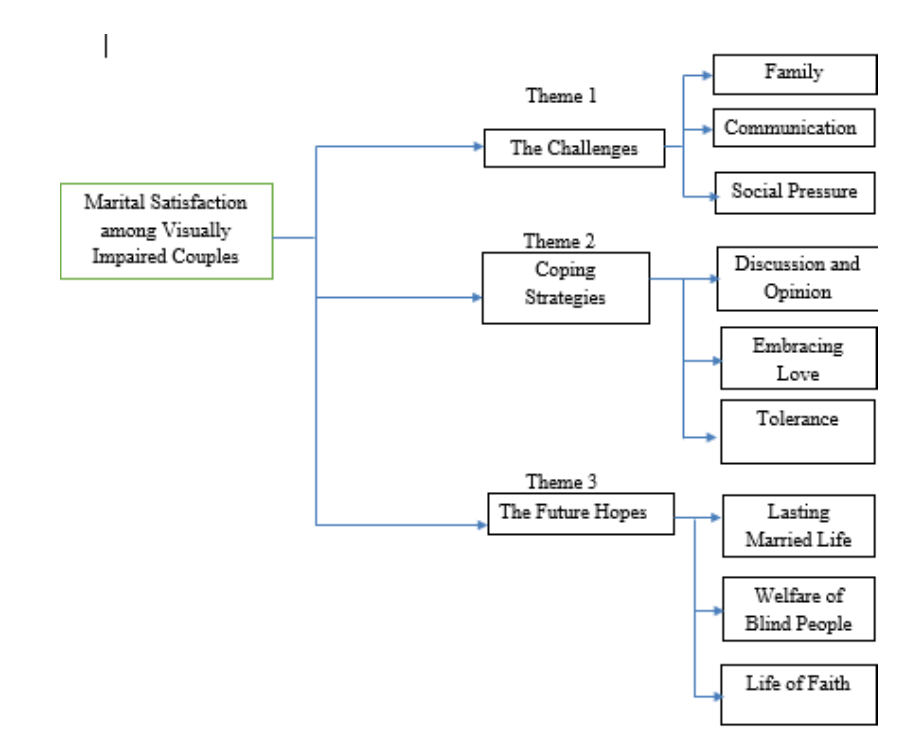
Figure 1 : Structural Overview of Three Major Themes and Sub-Themes